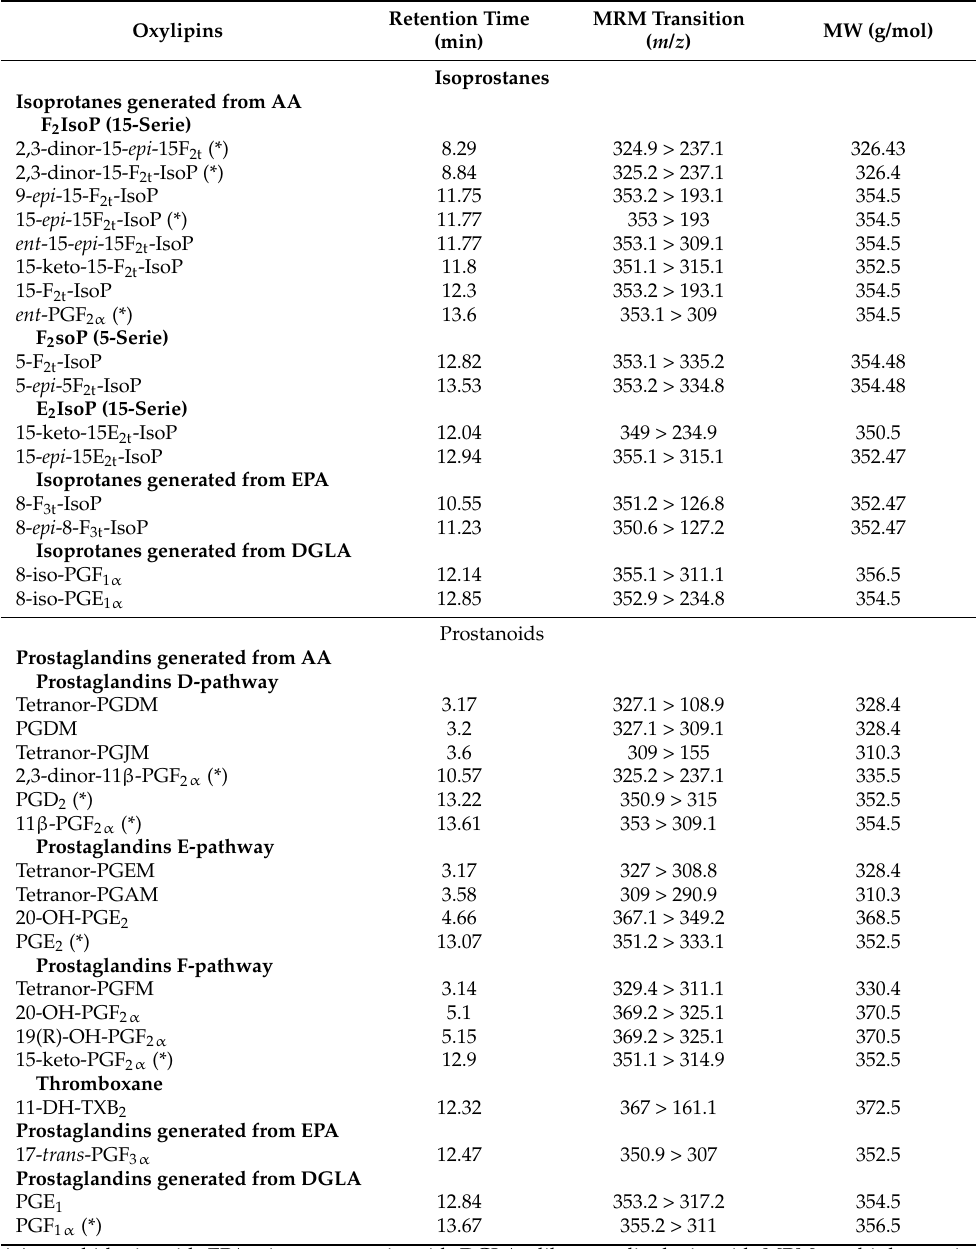
Table 1. Oxylipins analysed in the current